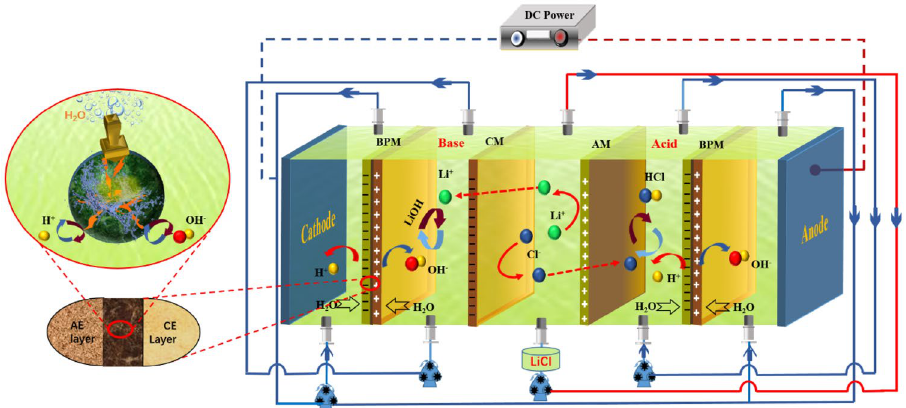
Fig. 1 Schematic of BMED for acid–base